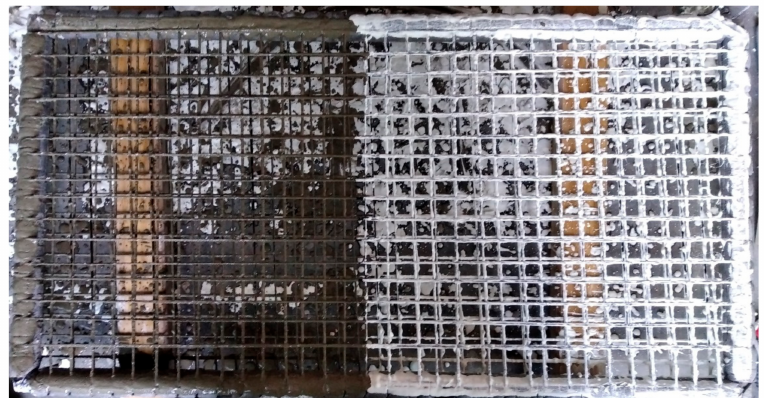
Figure 7. Preparation of reinforcement mesh: ( a ) Method of carbon mesh preparation (unit: mm); ( b ) Mesh from carbon roving saturated with cement suspension–surface application by roller (from left): CEM 42.5 R, CEM 52.5 R.